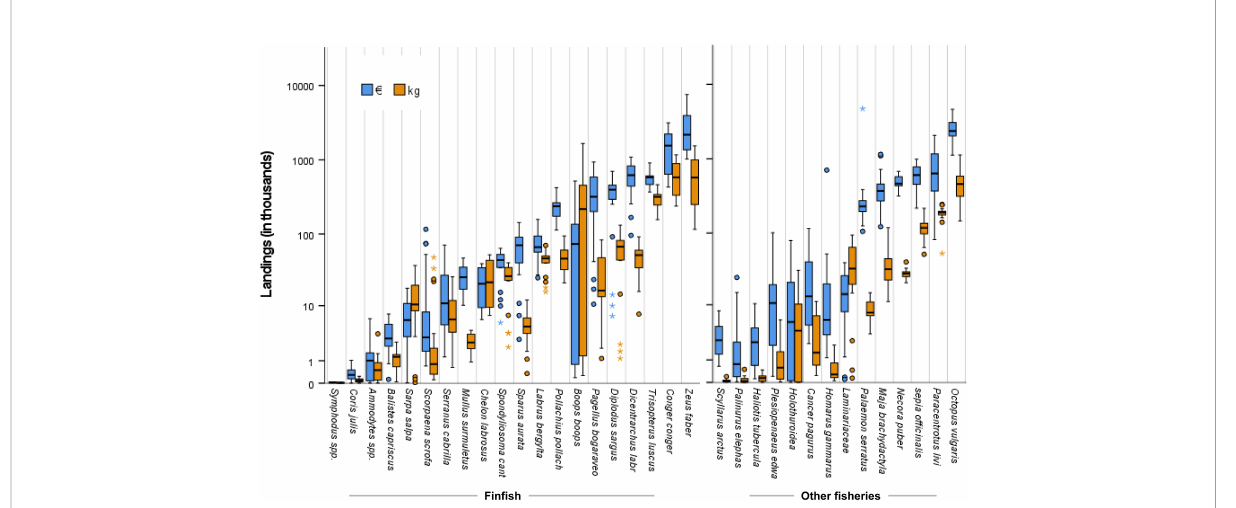
FIGURE 5 Landings data (2001 – 2021) in euros and kilograms for fi sheries typically linked to kelp forest areas in NW Spain. From bottom to top, boxplots show minimum, fi rst quartile, median, third quartile, and maximum. Outside (>1.5 times the interquartile range above or below the box) and far outside (>3 times the interquartile range) values are displayed as dots and asterisks,